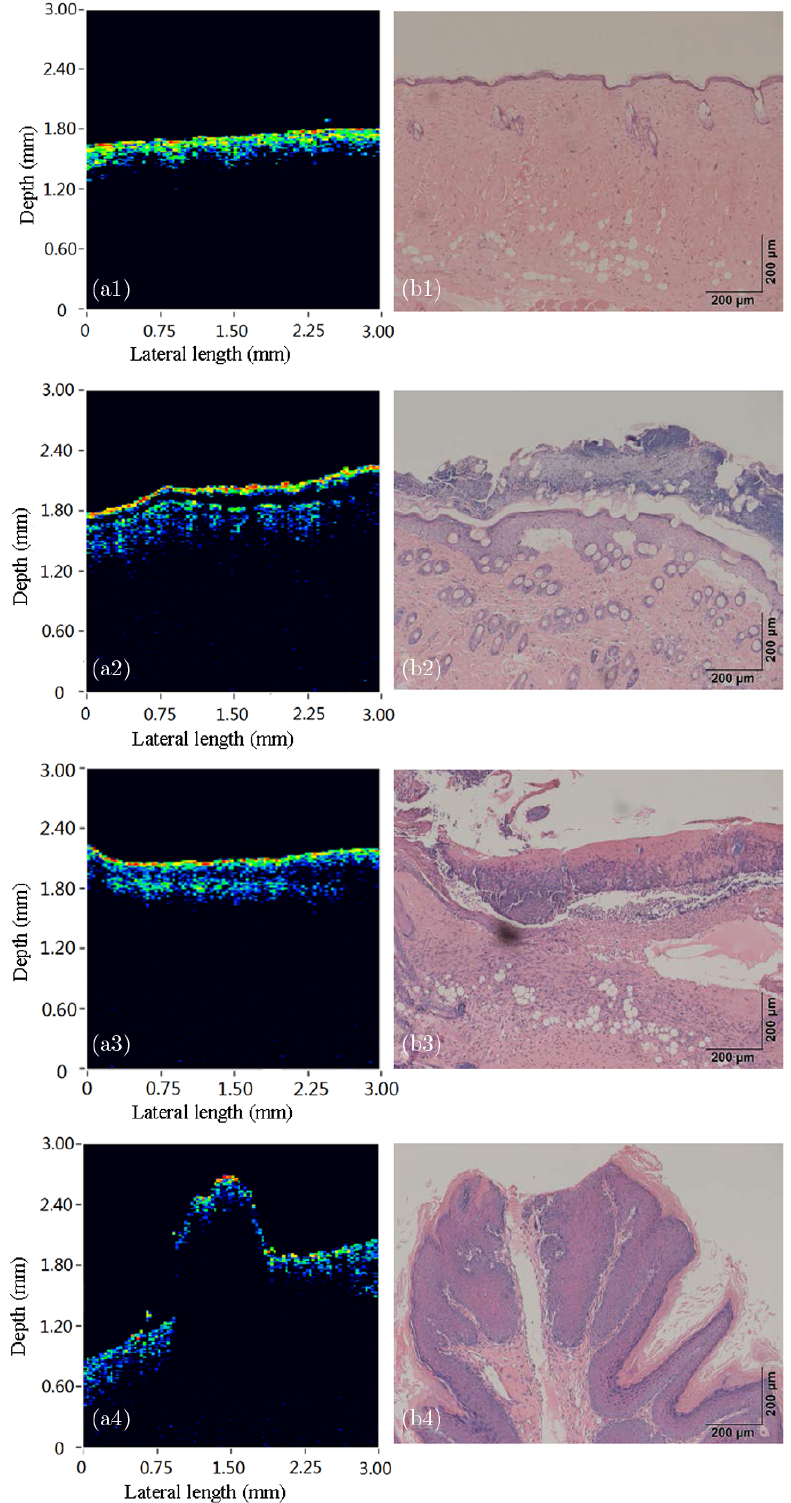
Fig. 1. OCT images and the histological images of di®erent time points. Left panel — OCT image, right panel — histological image. ( a 1) and ( b 1): un-irradiated skin; ( a 2) and ( b 2): Six weeks post-irradiation; ( a 3) and ( b 3): 20 weeks post-irradiation; and ( a 4) and ( b 4): 22 weeks post-irradiation. The scale bar is 200 (cid:1) m in H.E staining